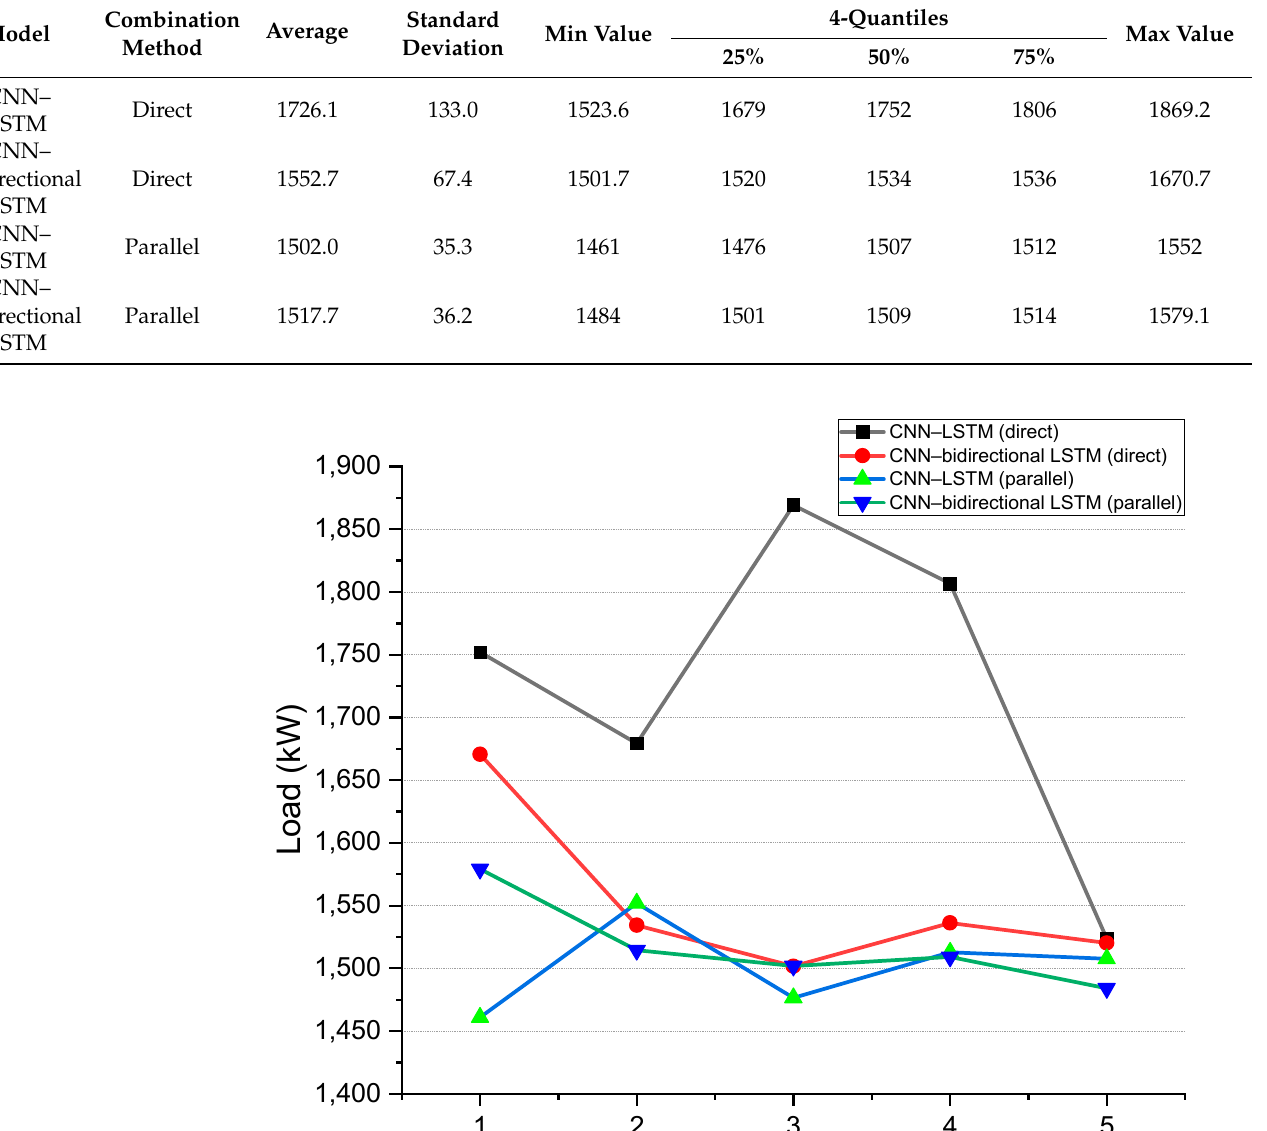
Table 5. Statistical information of RMSE of experiment results.